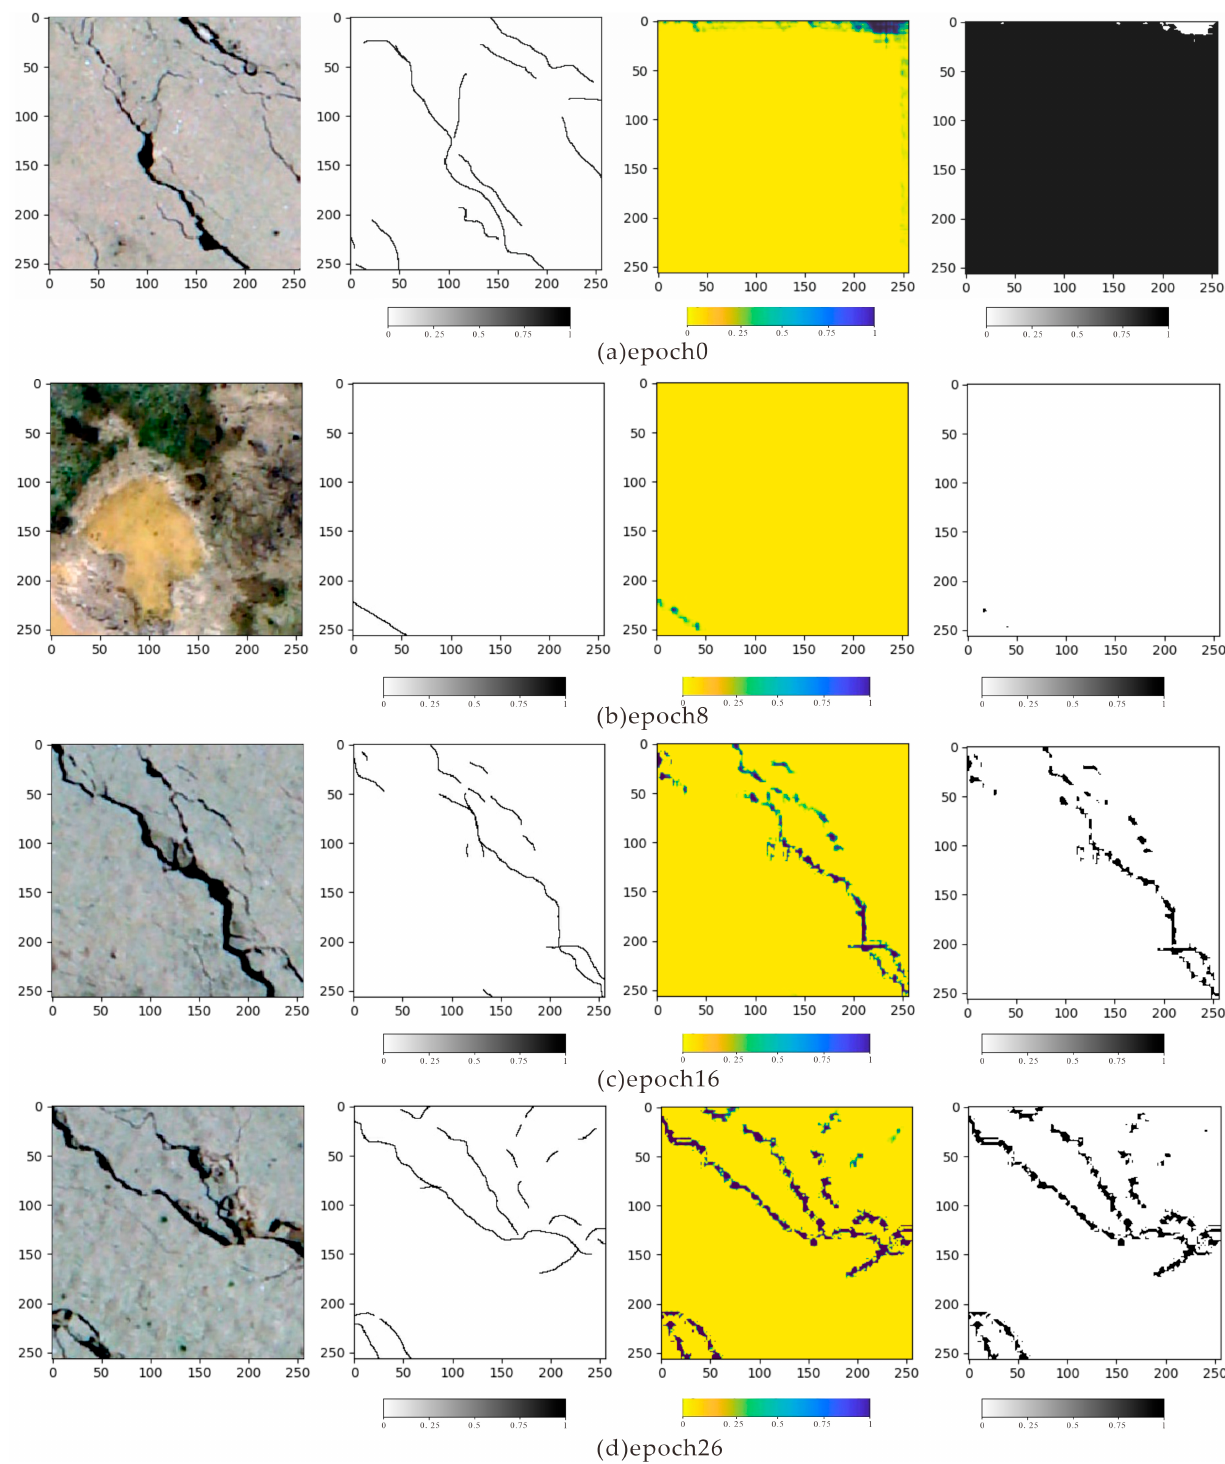
Figure 7. Training process of the crack identification model by applying maduoDom1.